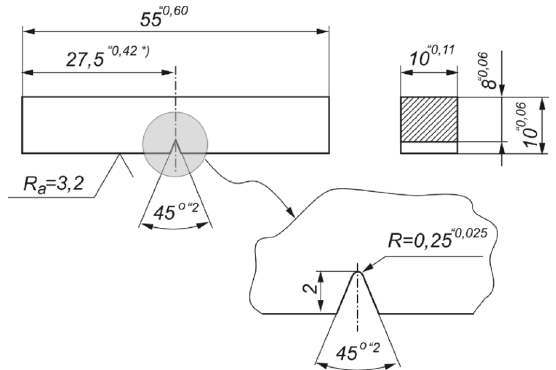
Figure 2. Charpy specimen for determining fatigue crack growth rate